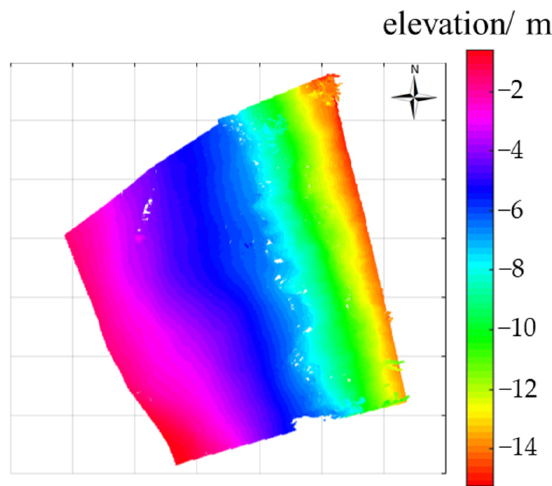
Figure 24. Lashagou NO.3 landslide DTM.